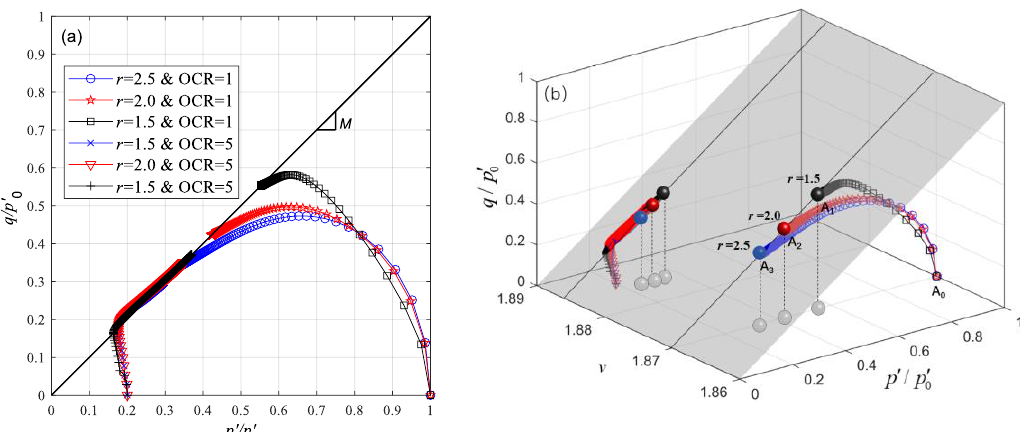
Figure 7. Influence of spacing ratio r on ( a ) stress paths and ( b ) critical states.